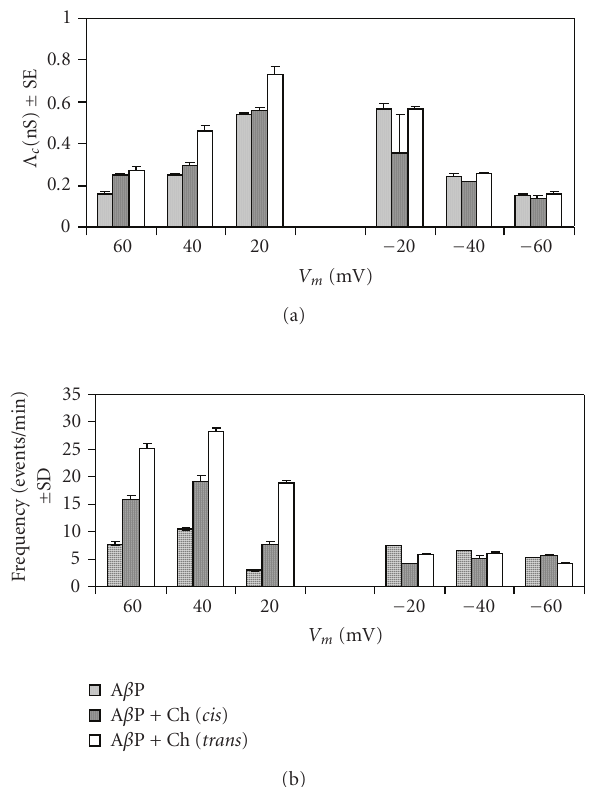
Figure 3: A β P1-40 channel mean conductance and frequency in OxCh PLM in the absence and in the presence of choline. (a) Λ c ± SE and (b) frequency ± SD of A β P1-40 channel without and with choline (5 × 10 − 11 M) added to the cis or trans side of the chamber in OxCh PLM. The minimum and maximum number of channels considered ( N ) out of a total number of channels considered ( N t ) was: A β P1-40, 448 < N < 2080, N t = 5493; A β P1-40 + choline cis , 115 < N < 898, N t = 2269; A β P1-40 + choline trans , 448 < N < 948, N t = 3844.